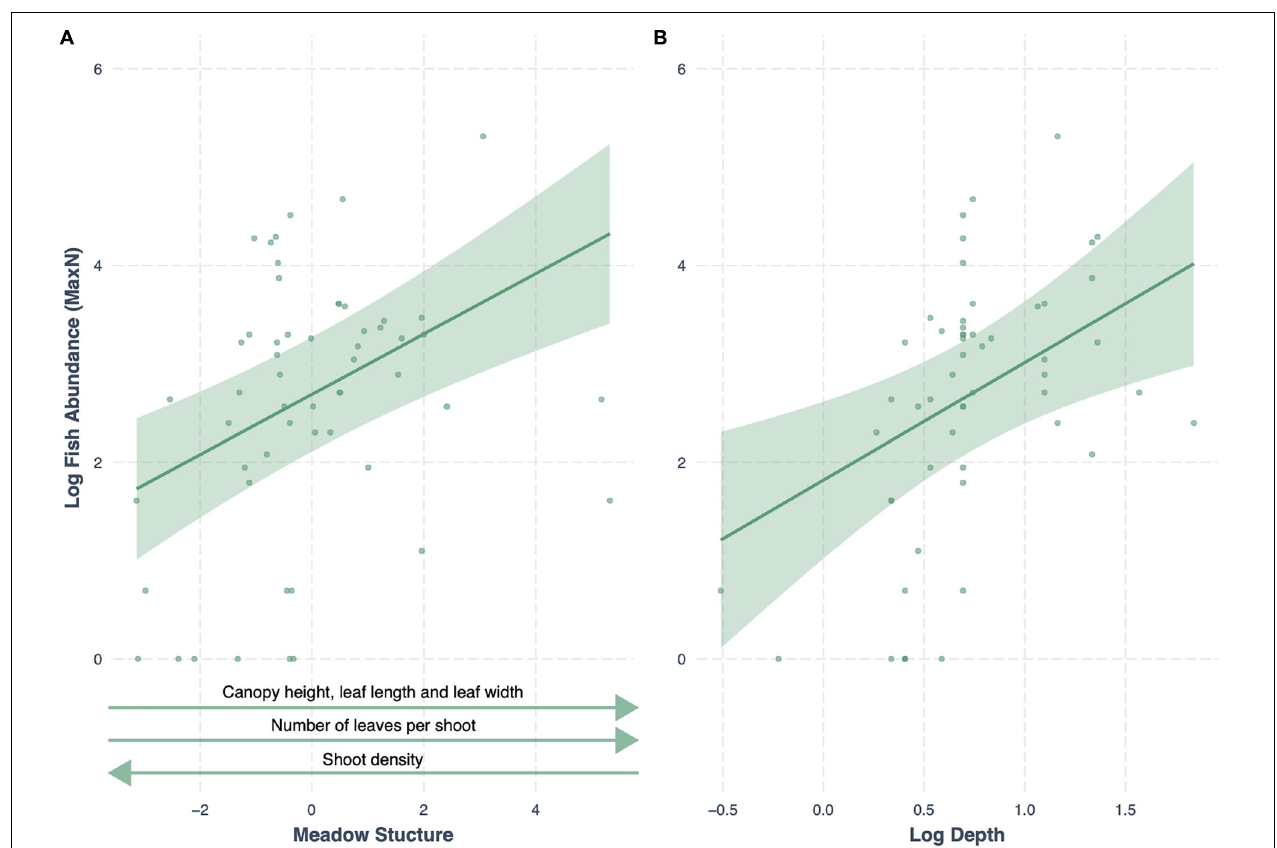
FIGURE 3 | Conditional effect plots for the model best predicting log fish abundance (R 2 = 0.73) in tropical seagrass meadows across 12 sites. Predictor variables include (A) meadow structure (inverse of PC1) and (B) log depth (m). Shaded areas represent 95% confidence intervals, reflecting the variance of the fixed effects.